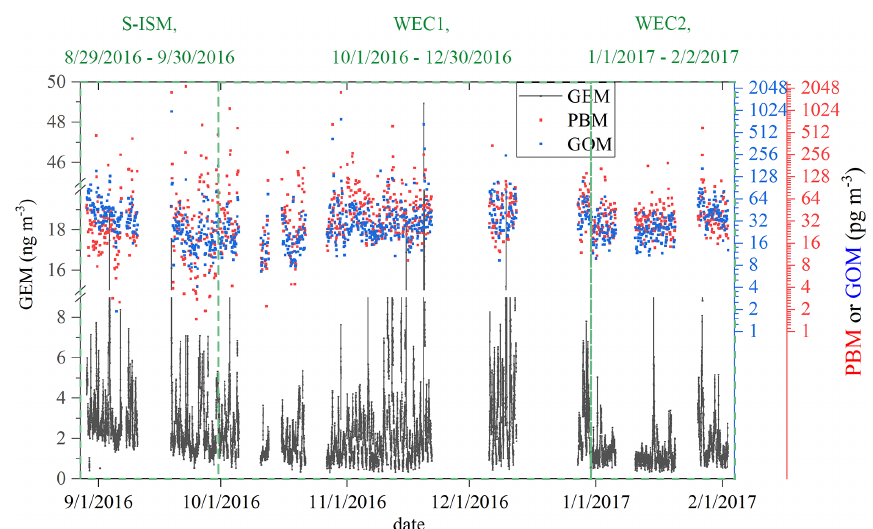
Figure 2. Time series of GEM, GOM, and PBM concentrations over the sampling period. The GEM concentration resolution was 5min, and the GOM and PBM resolutions was